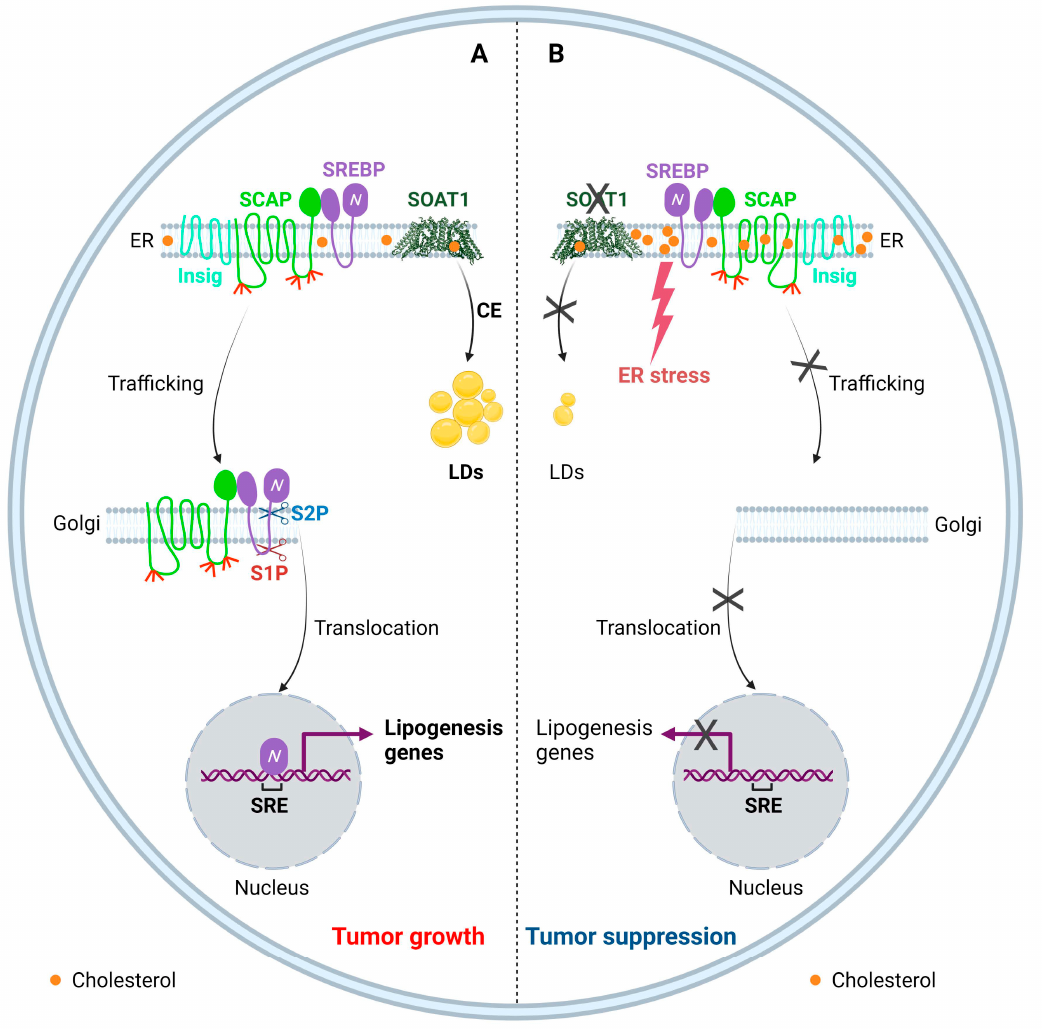
Figure 2. Targeting SOAT1 to disrupt cholesterol homeostasis for GBM therapy. ( A ) SOAT1 catalyzes the esterification of cholesterol to store excess free cholesterol into LDs, and thus is involved in maintaining cellular cholesterol homeostasis. Cholesterol negatively regulates SCAP/SREBP trafficking and SREBP activation. Cholesterol reduction in the ER activates SCAP dissociation from Insig, resulting in SREBP translocation and activation to promote lipogenesis. ( B ) Inhibition of SOAT1 reduces CE formation, which in turn results in the accumulation of cholesterol in the ER membrane, subsequently leading to the SCAP/SREBP complex remaining in the ER and to reduction of lipogenesis, along with enhanced ER stress, resulting in tumor suppression.